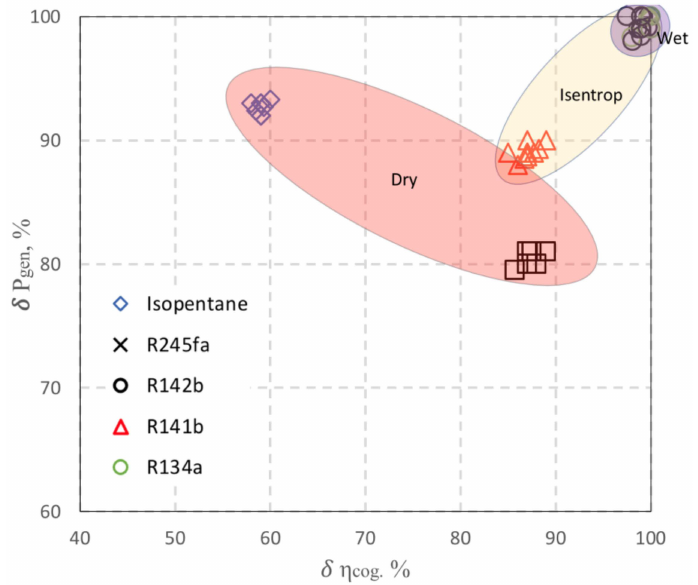
Figure 7. Comparative evaluation of working fluid type to energy indicators according